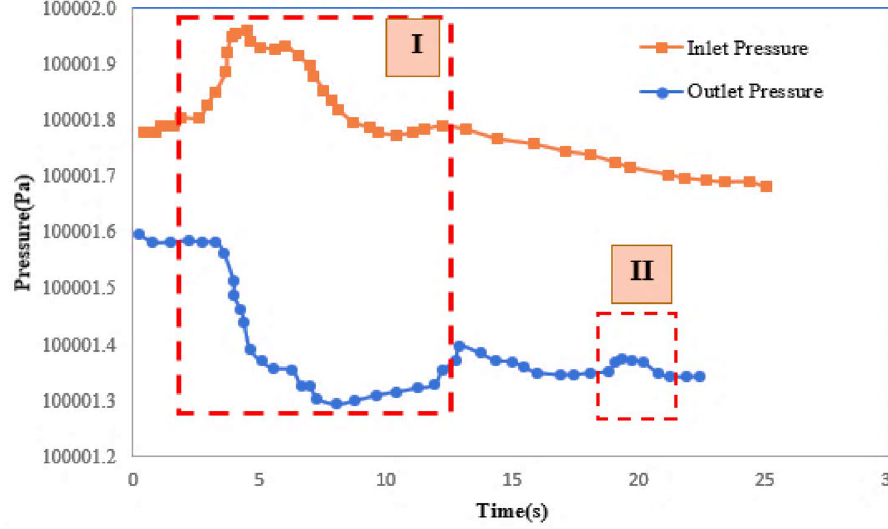
Figure 9. Pressure variations at inlet and outlet of the micromodel for the breakage mechanisms.